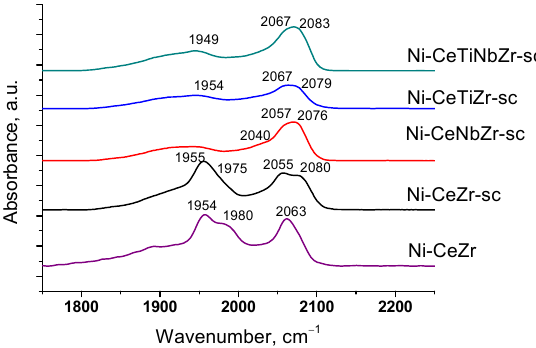
Figure 3. Differential FTIR spectra of CO adsorbed on catalysts at CO pressure 10 Torr and room temperature. Table 4. Concentration of various type of surface carbonyls according to IR spectroscopy.